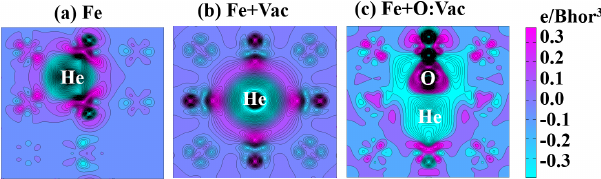
Figure 2. The change in the charge density of Fe on the (0 2 0) plane due to the He atom: ( a ) A tetrahedral interstitial He in a perfect Fe lattice; ( b ) a He trapped at the vacancy site of a Fe lattice; and ( c ) a He trapped with the O:Vac (Vac, vacancy) pair in a Fe